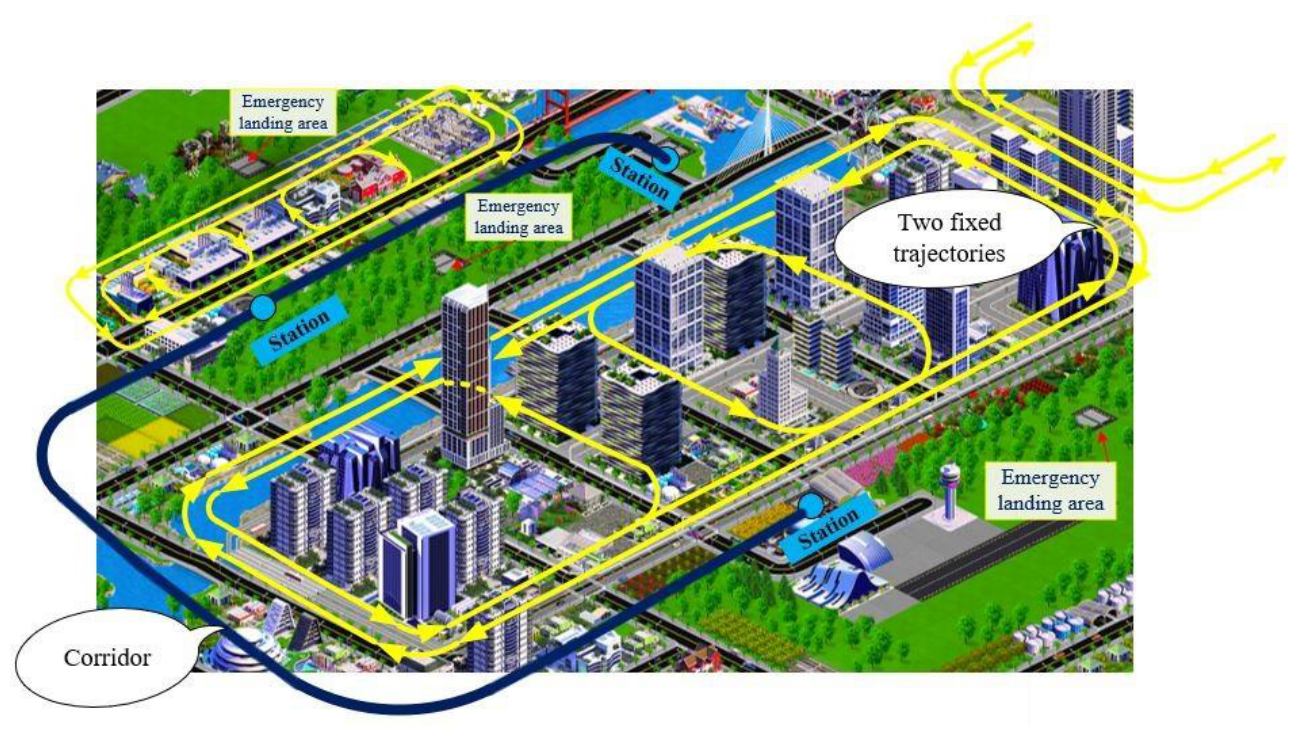
Figure 1. Recommended concept (following to initial idea of Kin Huat Low [19]).